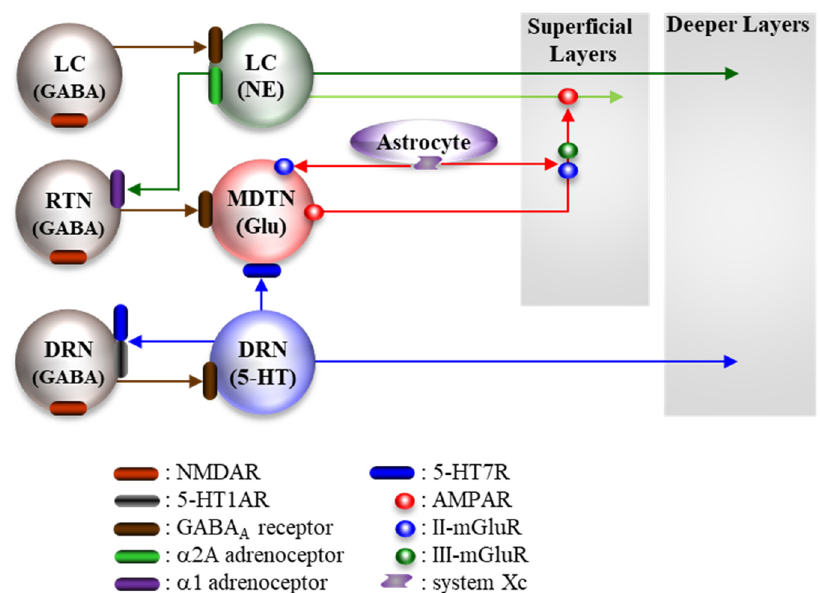
Figure 2. Proposed hypothesis for the extended complicated neural circuit connectivities involved in the thalamocortical cognitive glutamatergic pathway, from the MDTN to the frontal cortex; the mesothalamic serotonergic pathway, from the DRN to the MDTN; the mesothalamic noradrenergic pathway, from LC to the RTN; the mesocortical catecholaminergic pathway, from the LC to the frontal cortex; the mesocortical serotonergic pathway from the DRN to the frontal cortex. Generally, both noradrenergic and serotonergic neurones project selective terminals to deeper layers of the frontal cortex; however, some neurones in the LC project catecholaminergic co-releasing terminal (co-releasing norepinephrine with dopamine) to superficial layers of the frontal cortex. Glutamatergic projection from the MDTN presynaptically activates catecholaminergic co-releasing terminals via AMPAR in the superficial layers of the frontal cortex. Glutamatergic neurones in the MDTN receive excitatory serotonergic input from DRN via 5-HR7R and inhibitory GABAergic inhibition from RTN. GABAergic neurones are regulated by excitatory NMDAR and receive excitatory noradrenergic input from LC via α 1 adrenoceptors.